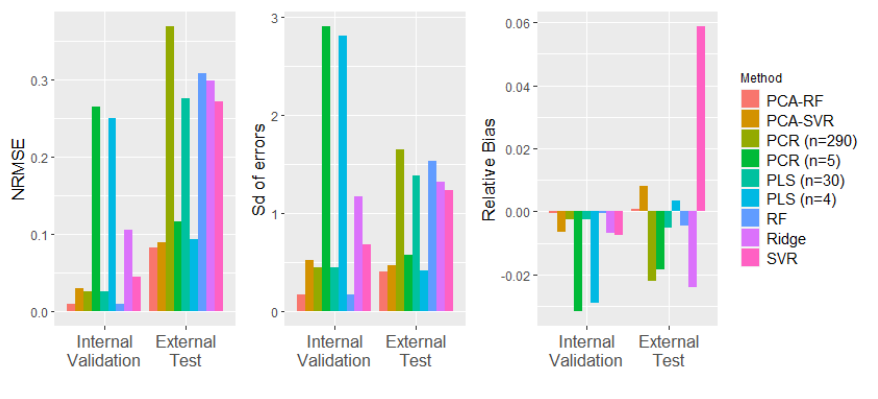
Figure 2. NRMSE, SD of errors, and relative bias for all soft sensors.